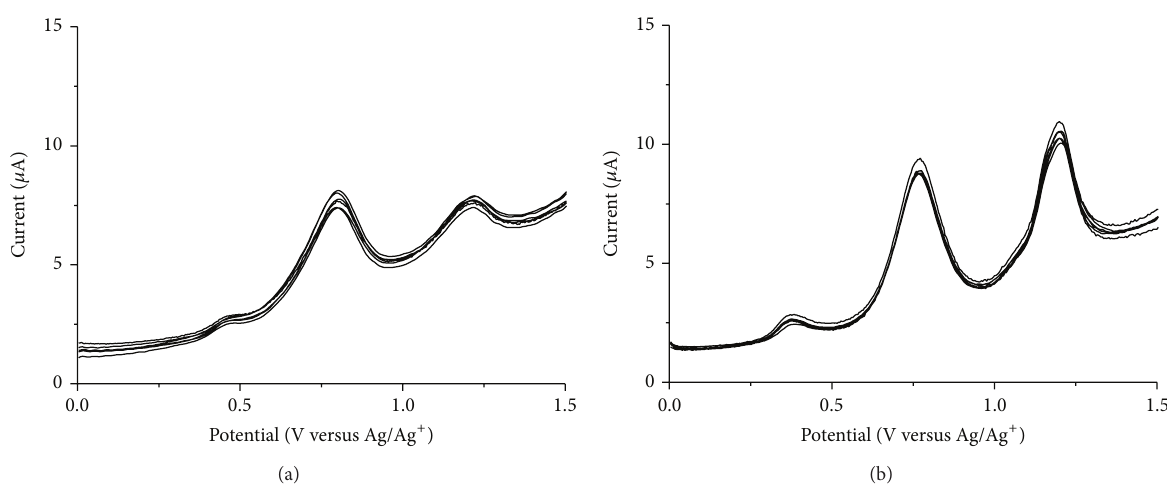
Figure 2: DPVs of (a) o -CAC and (b) o -EAC (1 × 10 −4 M) in the absence and presence of alkali metal ions (1 × 10 −4 M).